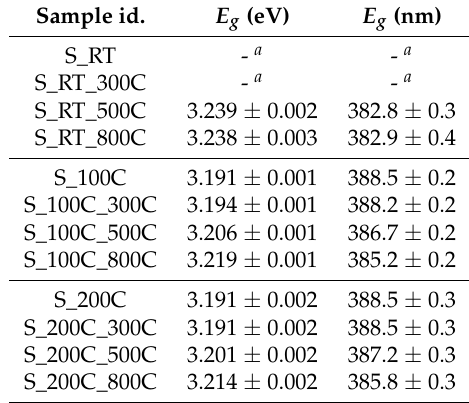
Table 3. The band-gap energy ( E g ) estimated for the deposited films. Sample id. E g (eV)